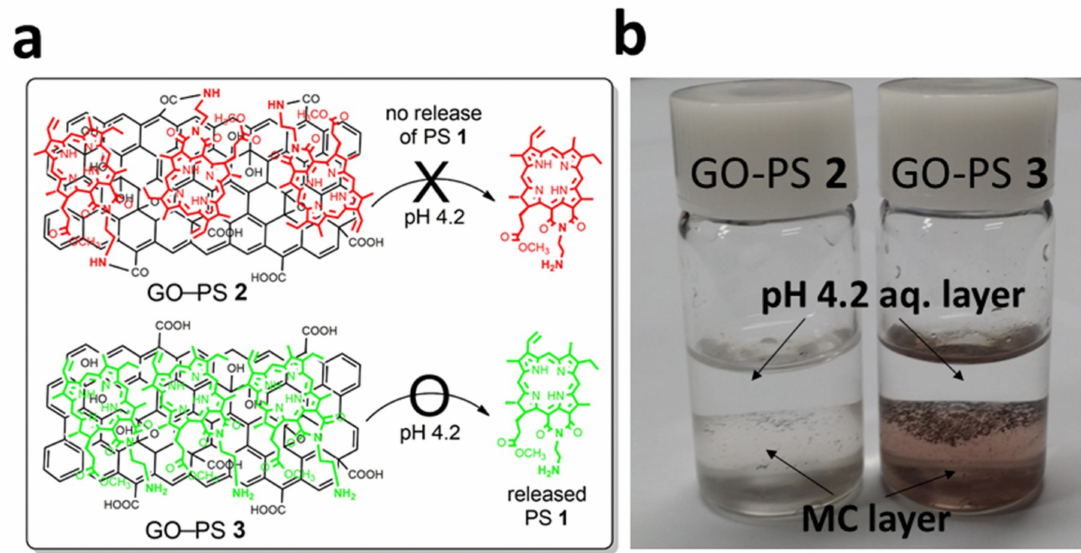
Figure 2. pH-induced release test of PS 1 in GO–PS 2 and 3 at the pH 4.2 aqueous layer into the methylene chloride (MC) layer. ( a ) A schematic presentation. ( b ) No release of PS 1 from 2 (colourless MC layer) and release of PS 1 from 3 (pink coloured MC